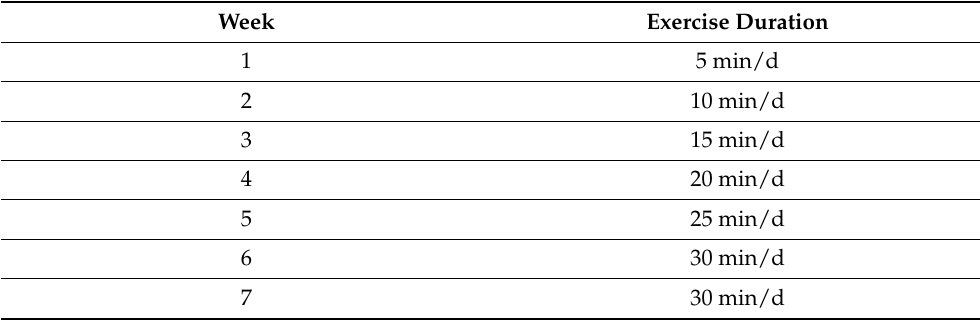
Table 1. Exercise protocol for treadmill, small circle, and large circle treatment groups. All exercise was performed 5 d/wk at a speed of 1.1–1.5